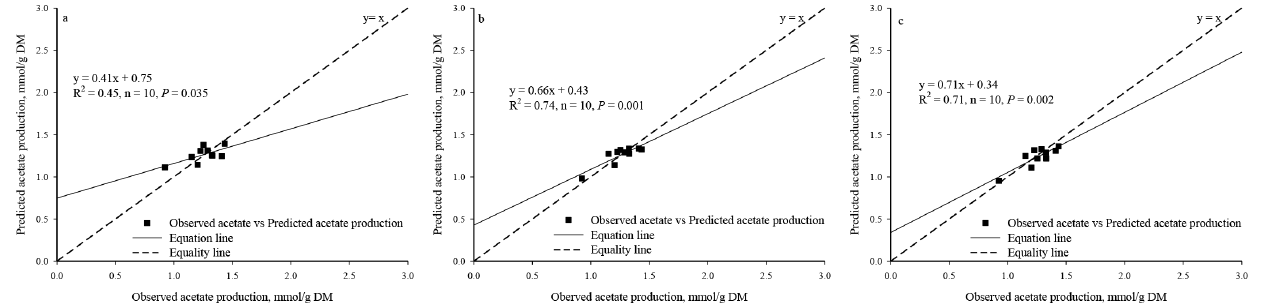
Fig. 3. Relationship between the observed vs. the predicted acetate production. ( a . Predicted values were from Equation I; b . Predicted values were from BP3 model where acetate production using as individual output; c . Predicted values were from BP3 model where acetate production was output